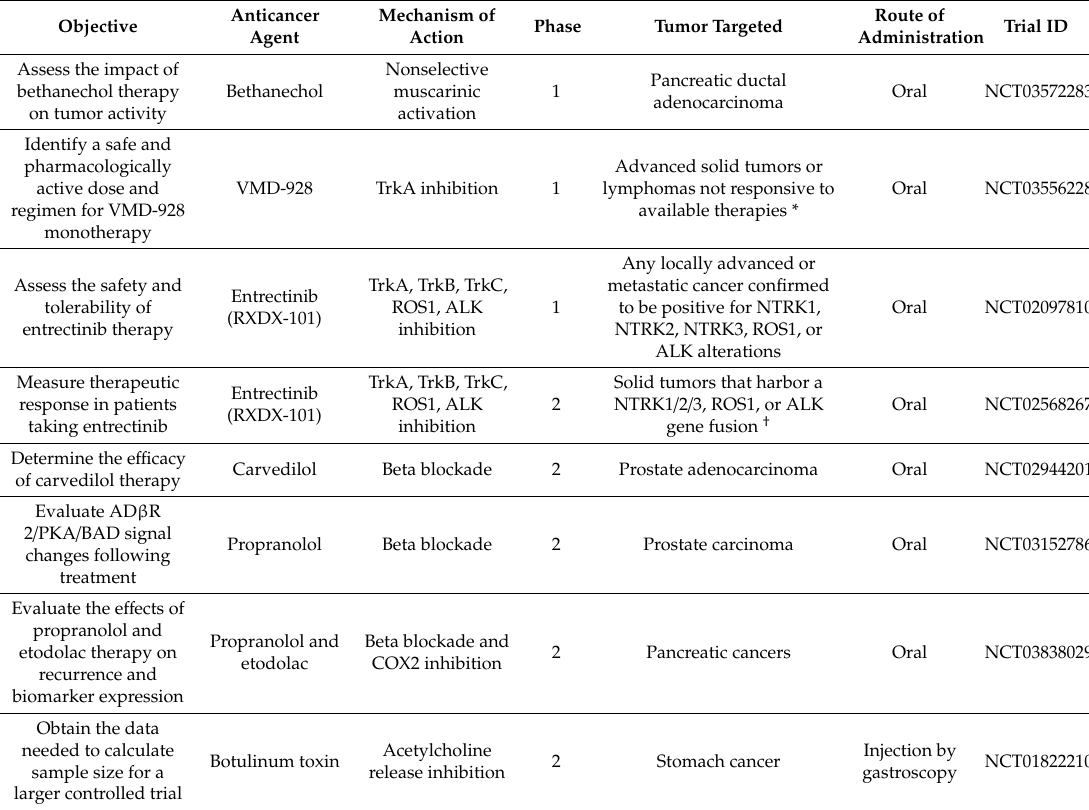
Table 2. Active interventional clinical trials targeting neuron–tumor